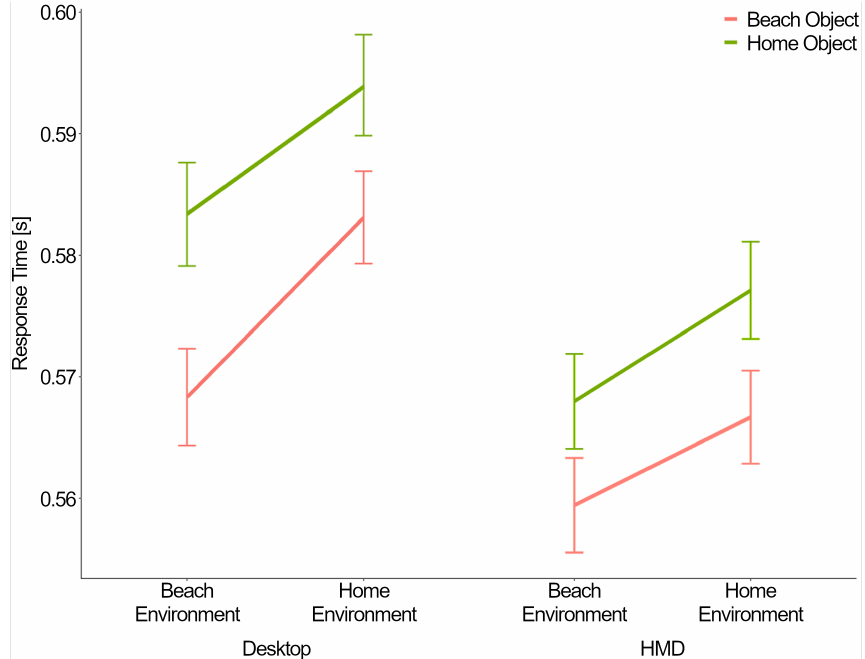
Figure 10. Three-way interaction effect between immersion level (Desktop/HMD), test object category (Beach/Home), and the environment type (Beach/Home) on response